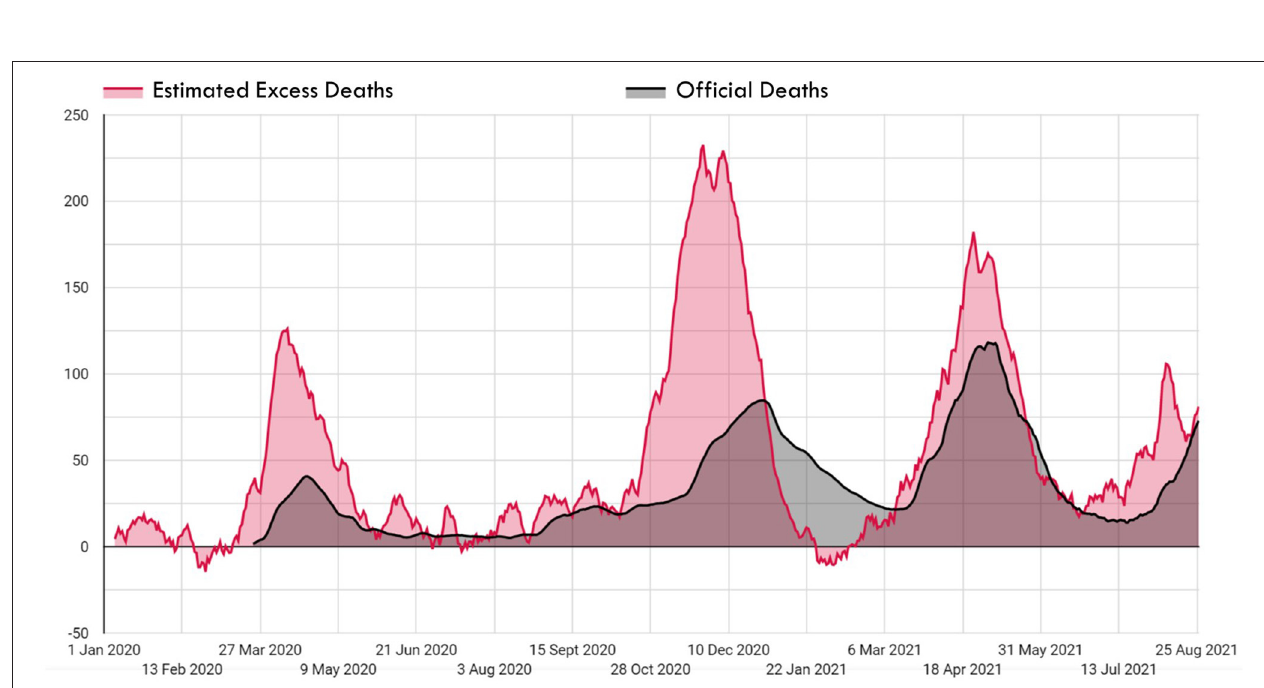
FIGURE 4 | Excess deaths and official deaths during the COVID-19 pandemic in Istanbul.